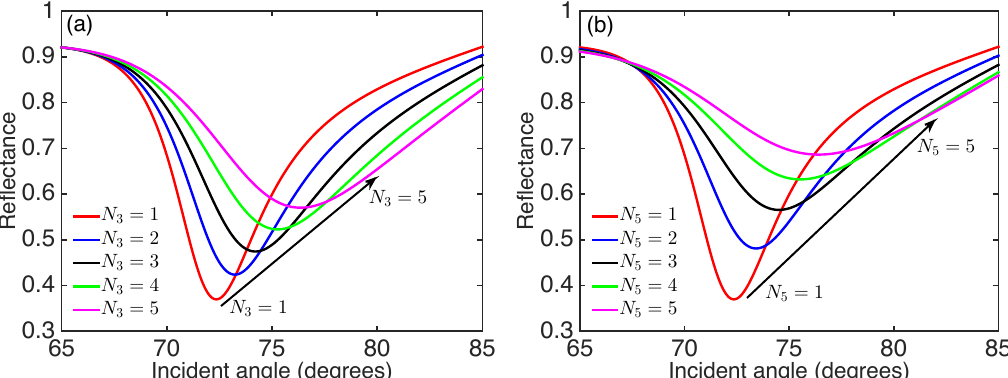
Figure 3. Reflectance as a function of the incident angle for Ti 3 C 2 T x -MoS 2 -based SPR sensor with ( a ) different number of MoS 2 ( N 3 ) and monolayer Ti 3 C 2 T x ( N 5 = 1), and ( b ) different number of Ti 3 C 2 T x ( N 5 ) and monolayer MoS 2 ( N 3 =